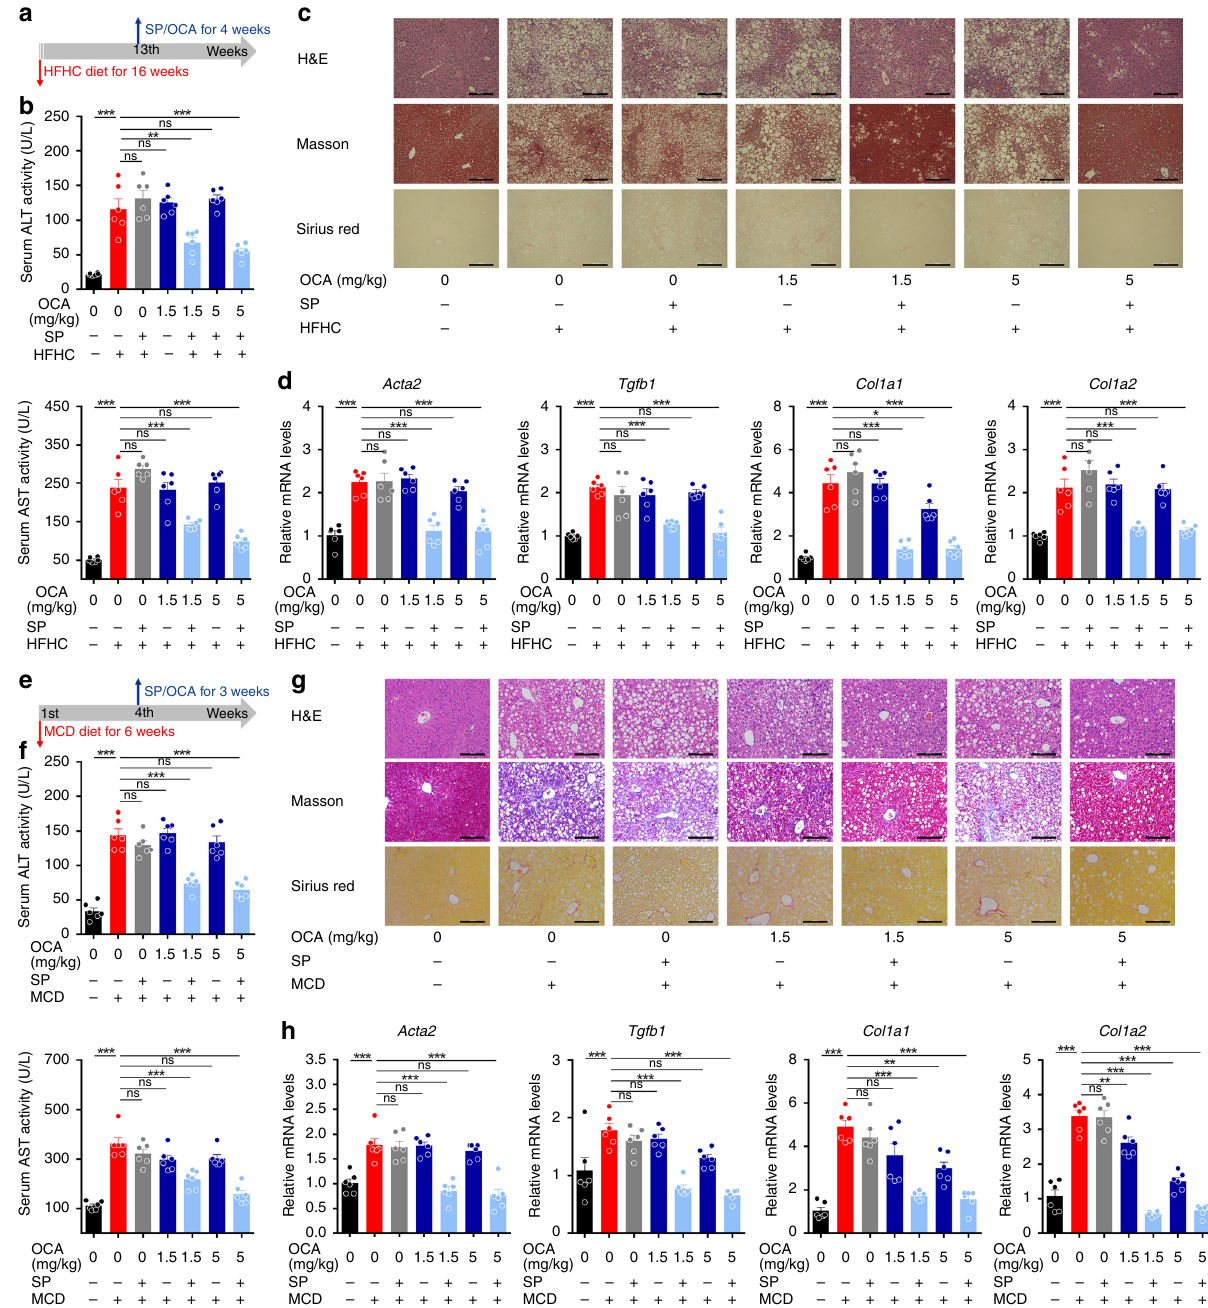
Fig. 7 SUMOylation inhibition restores the anti- fi brotic activity of OCA in NASH models. Mice were fed with HFHC a – d or MCD e – h diet to induce NASH-associated fi brosis and treated with OCA in the presence or absence of SP. n = 6 biologically independent samples within these experiments. a and e Mouse experiment procedure schemes. b and f Serum ALT and AST levels. c and g H&E, Masson, and Sirius red staining of liver sections (representative of n = 6 biologically independent samples. Scale bar, 100 μ m). d and h mRNA expression of pro- fi brotic genes. Results are mean ± SEM, * P < 0.05, ** P < 0.01, *** P < 0.001, and ns, statistically not signi fi cant, as assessed with